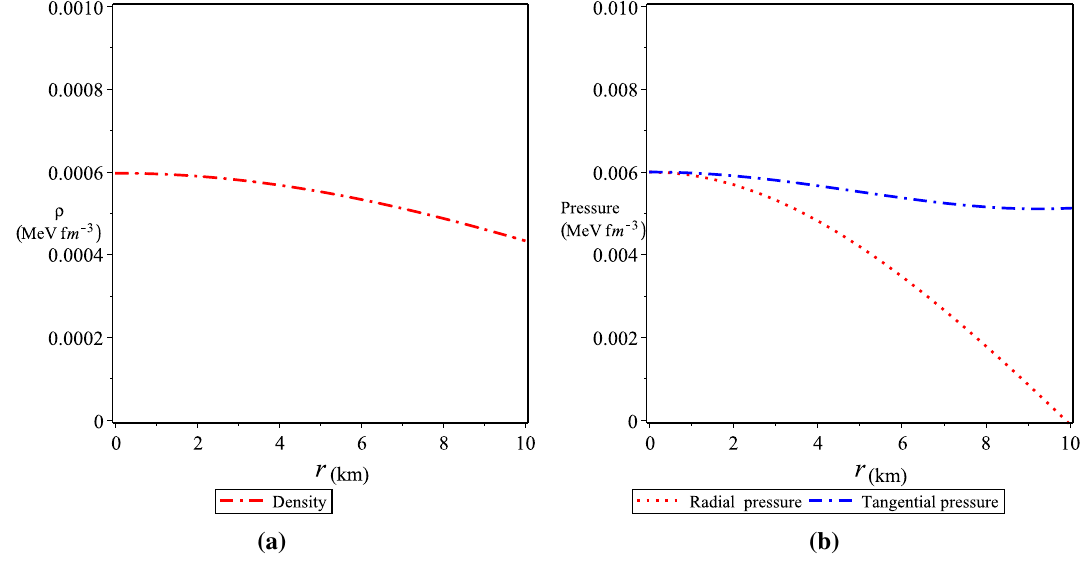
Fig. 2 Plotsofthedensity,radialandtangentialpressuresof(26)vstheradialcoordinate r inKmadoptingPSRJ1614-2230 constraints.According to this, we assume the values of constants as k ∼ 28 . 248, c 2 ∼ 0 . 003, k 1 ∼ 0 .